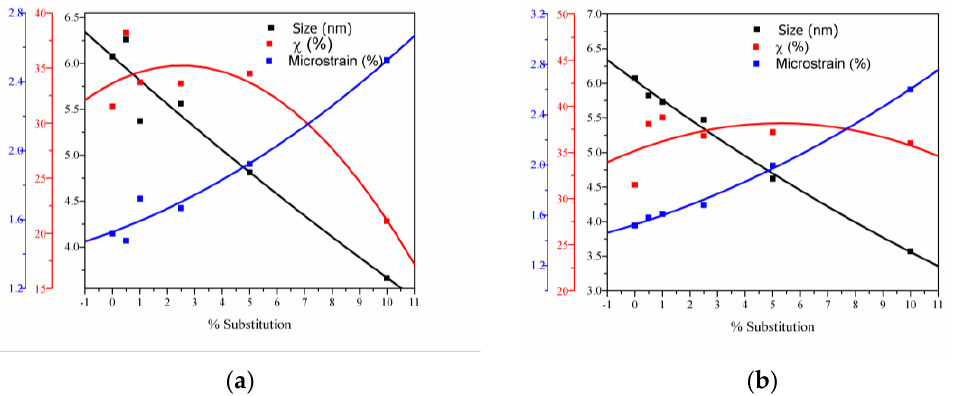
Figure 4. ( a ) The estimated crystallite size, lattice microstrain, and degree of crystallinity for Ca 10 − x Ce(III) x (PO 4 ) 6 (OH) 2 ; ( b ) the estimated crystallite size, lattice microstrain, and degree of crystallinity for Ca 10 − x Ce(IV) x (PO 4 ) 6 (OH) 2 .